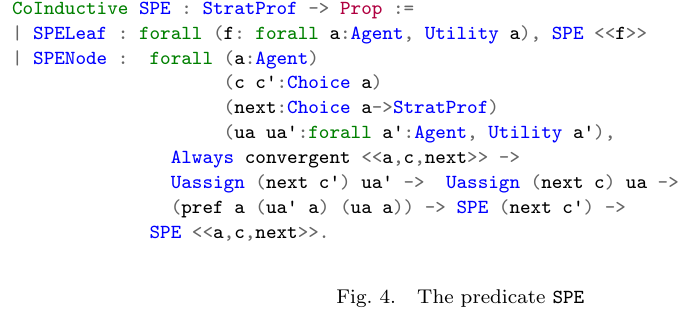
Fig. 4. The predicate